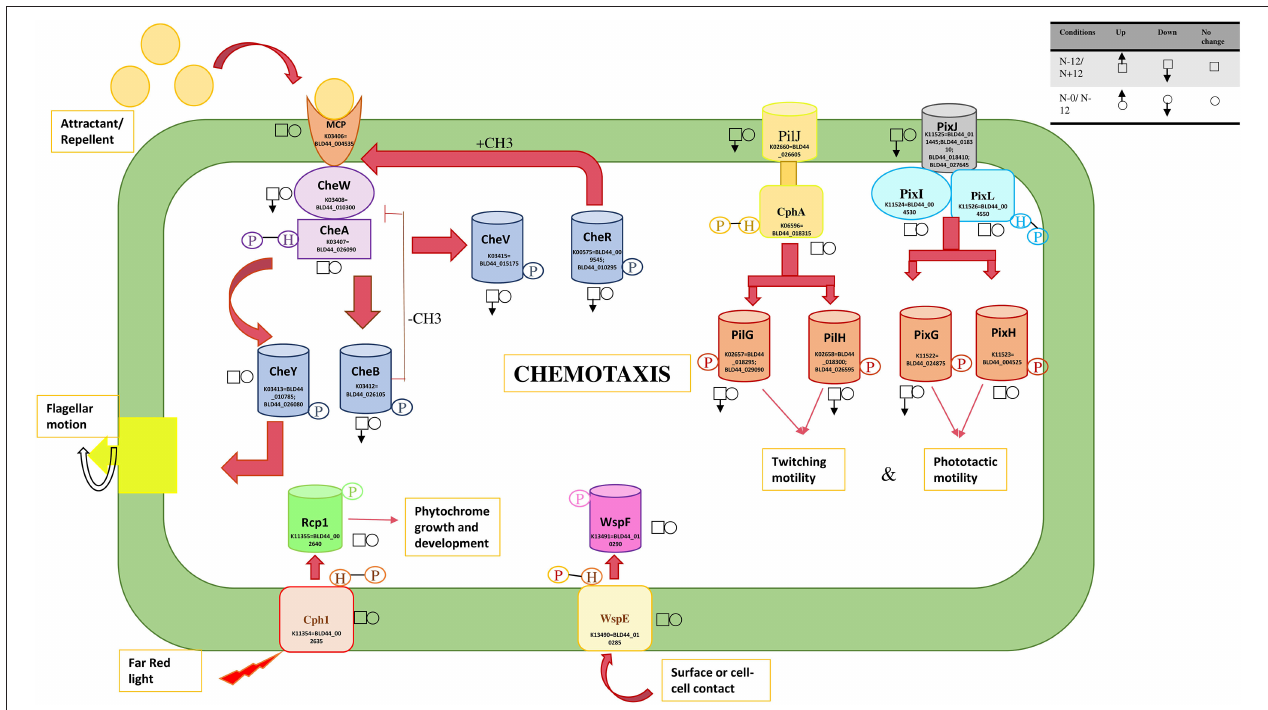
FIGURE 6 | Response regulators involved in the movement and their expression levels under nitrogen and nutrition stress. The square boxes represent expression during nitrogen stress in N– condition on the 12th day as the reference and are compared with the N + condition on the 12th day. For nutrition stress, circles are used with up and down arrows to represent upregulation and downregulation. The reference here is the 0th day under culture in N– conditions and is compared with the 12th day in culture under N– conditions. The signal transducers and response regulators are downregulated during the N + condition, leading to substantially reduced